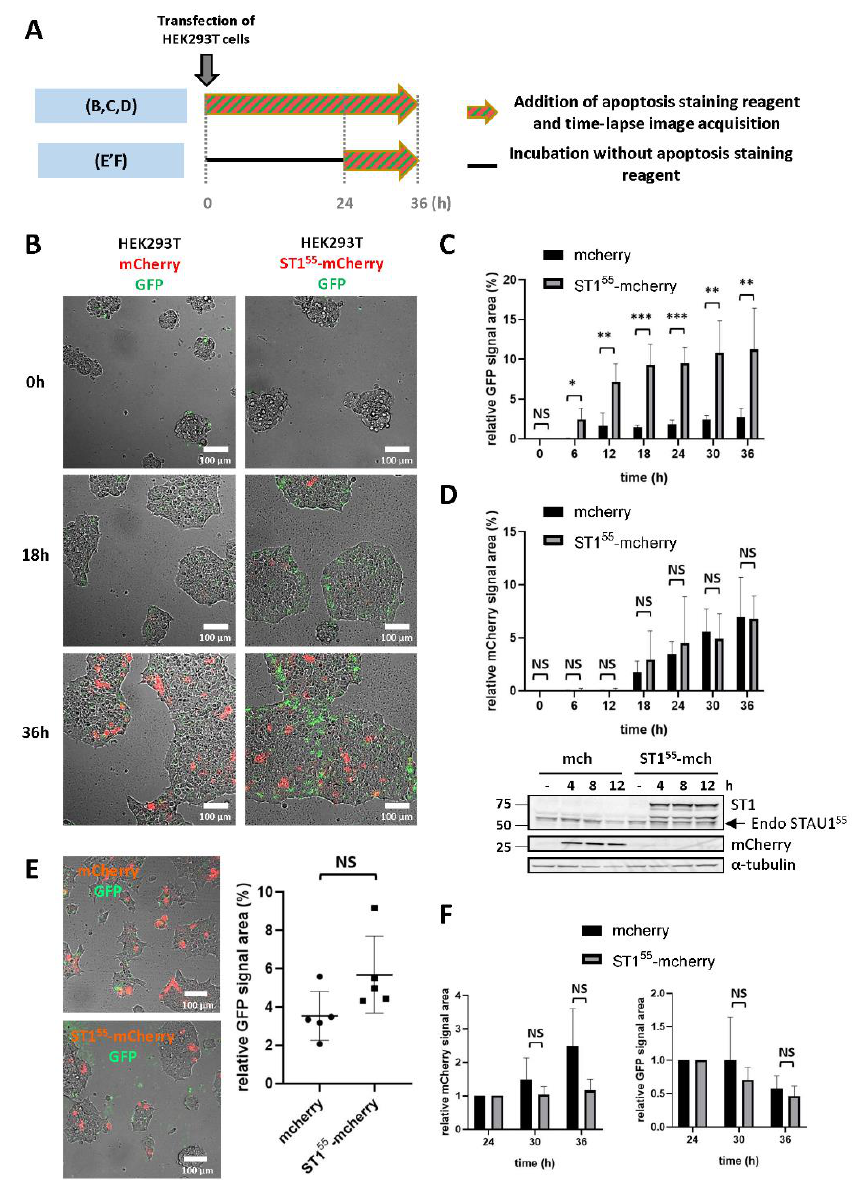
Figure 1. STAU1 expression induces apoptosis in transformed cells. ( A ) Schematic